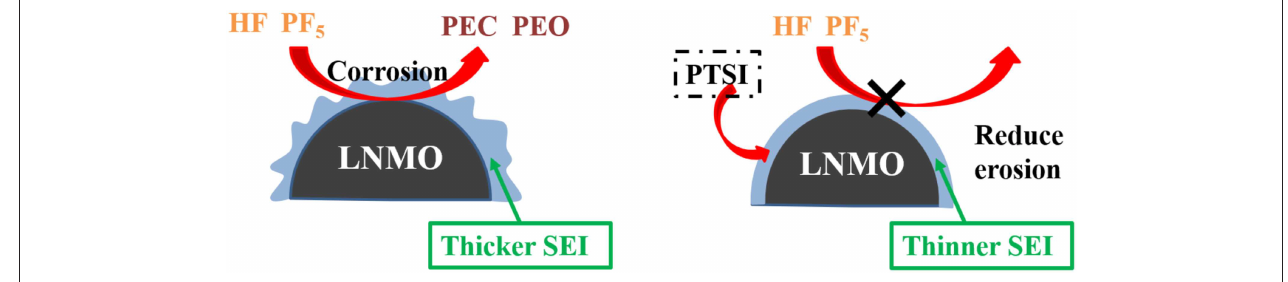
FIGURE 7 | Schematic illustration of the effect of the electrolyte without and with PTSI additives on the LNMO cathode surface.